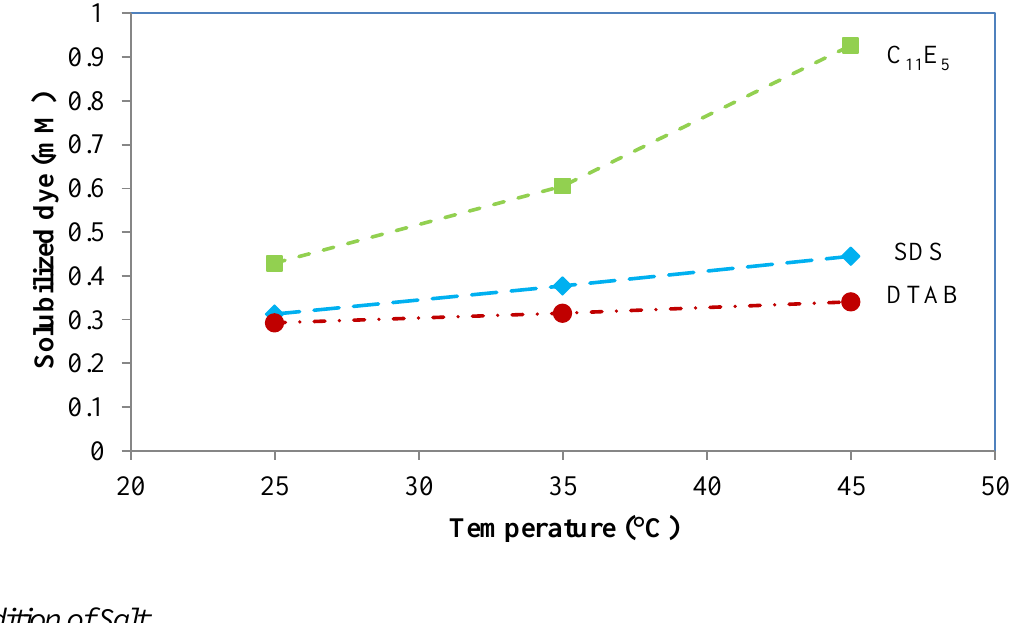
Figure 10. Amount of solubilized dye C.I. Solvent Yellow 14 (Sudan I) as a function of temperature for three different surfactants, the anionic sodium dodecyl sulfate (SDS), the cationic dodecyltrimethylammonium bromide (DTAB) and the nonionic penta(ethylene glycol)monoundecyl ether (C E ) at a fixed concentration of 10 g/L 11 5